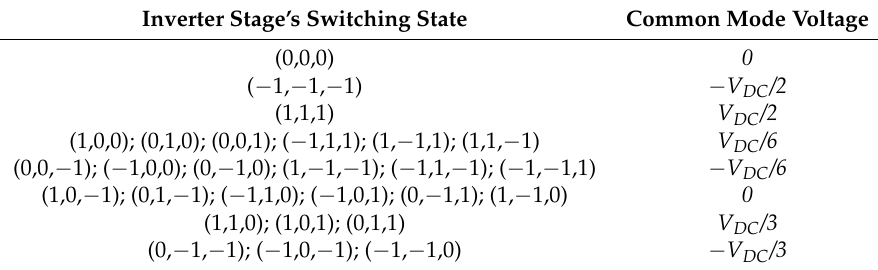
Table 5. The CMV of the 3-level T-Type NPC inverter.